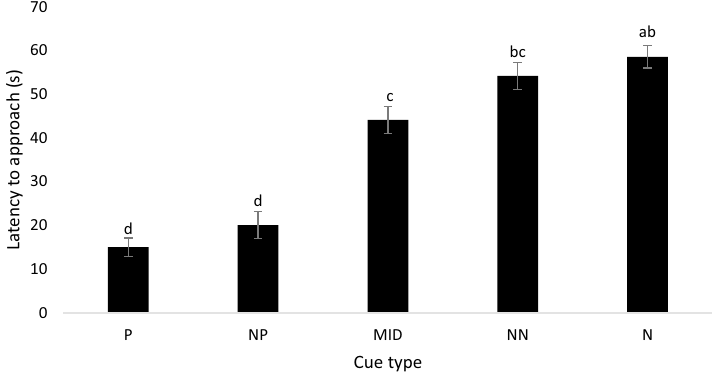
Figure 1. Least squares mean estimates (± SEM) for latency to approach (s) all five cues (positive [P], near positive [NP], middle [MID], near neutral [NN], and neutral [N]) in the judgement bias test for 4 test rounds (n = 9). Means with different superscripts ( a–d ) differ at p < 0.001.